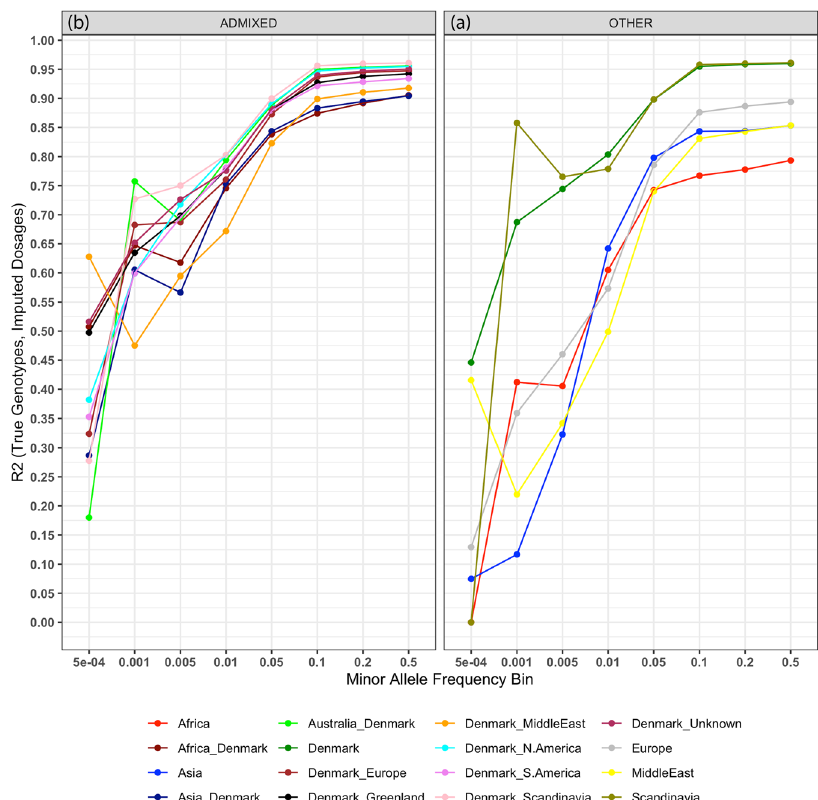
Fig. 3 The accuracy of imputation varies extensively by parental birthplace. a Shows the imputation accuracy ( r 2 ) in iPSYCH samples grouped by parental birthplace as ascertained from the Danish civil registers at different minor allele frequency bins within the 10,000 SNPs common to both genotyping arrays, masked prior to phasing. (Both parents were born in Africa: Red, Asia: Blue, Denmark: Dark Green, Scandinavia non-Danish: Light Green, Europe non-Danish or Scandinavian: Gray, Middle East: Yellow). b Shows the imputation accuracy ( r 2 ) in admixed samples where at least one parent was born in Denmark (Non-Danish parent born in Africa: Maroon, Asia: Blue, Australia: Fluorescent Green, Europe non-Danish or Scandinavian: Brown, Greenland: Black, Middle East: Orange, North America: Cyan, South America: Pink, Scandinavia non-Danish: Lavender, Unknown: Purple). All imputations were performed using a separate protocol, haplotype estimation was performed using BEAGLE5 phase-states = 560, imputations were performed using BEAGLE5.1 with the HRCv1.1 as the